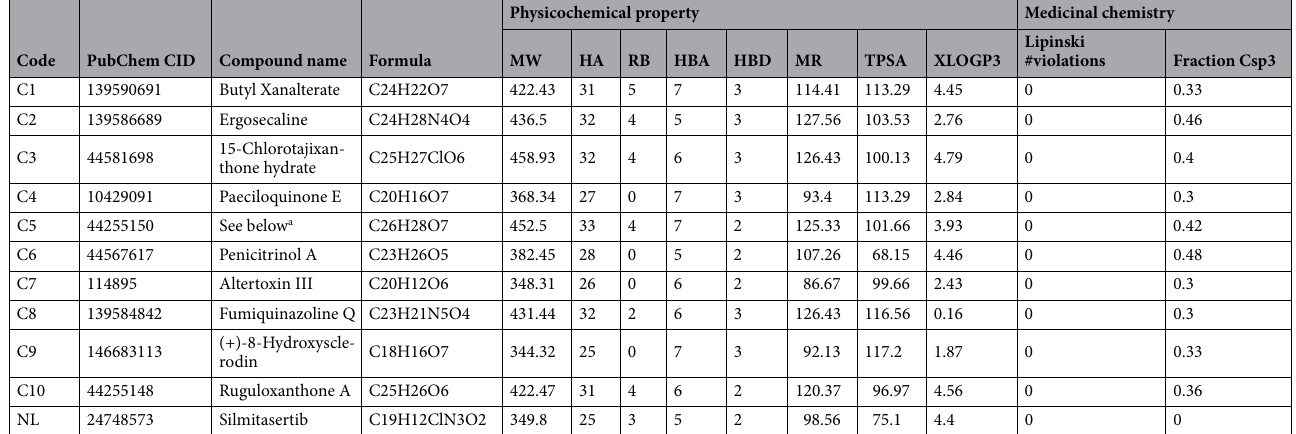
Table 2. Physiochemical and medicinal chemistry properties of top 10 best hits. a Compound name of